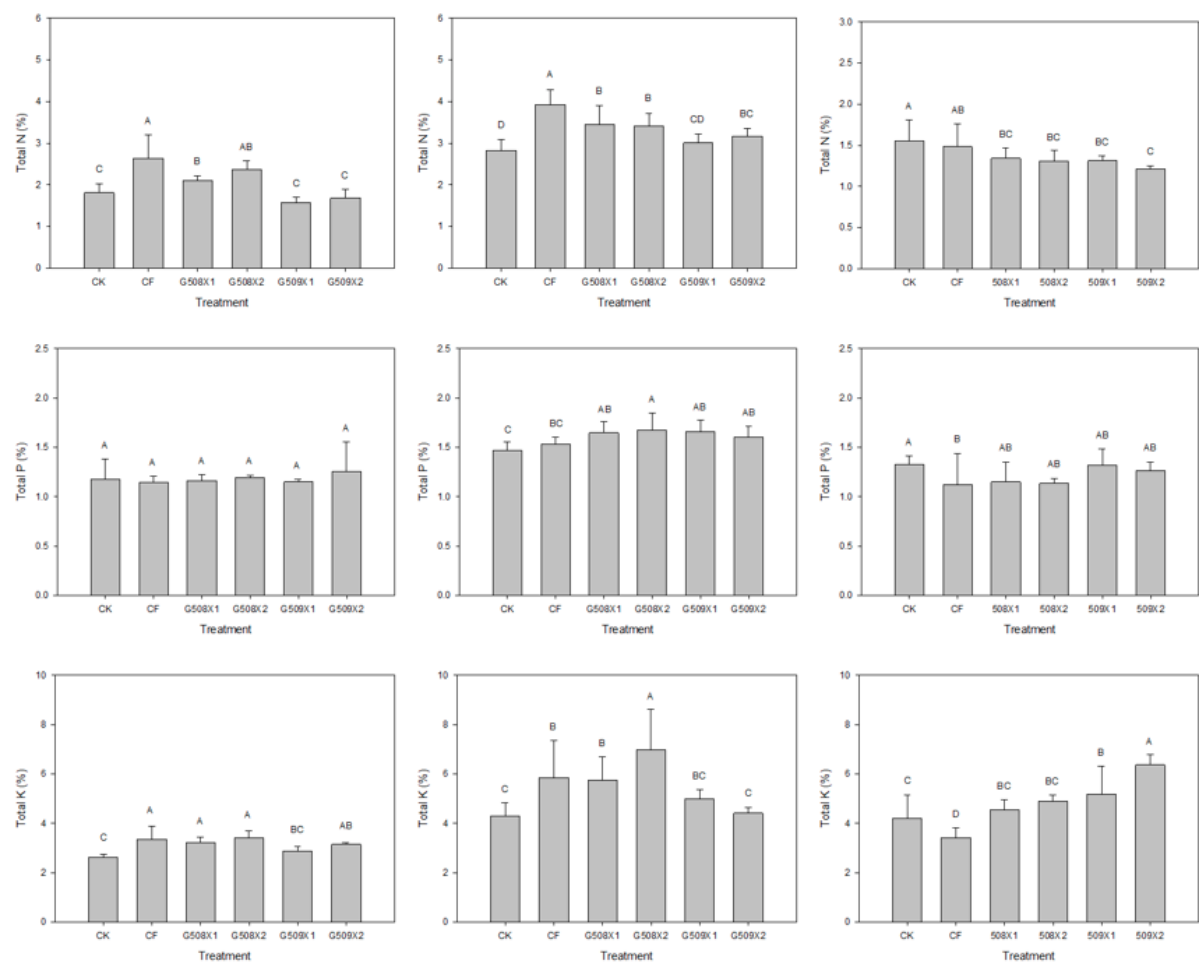
Figure 8. The total concentrations of N, P, and K of the different crops under different treatments: cabbage ( left ), Chinese cabbage ( middle ), and water spinach ( right ). The different letters indicate the significance among the treatments obtained through one-way ANOVA analysis (Duncan test, p < 0.05, n = 4). The codes have the same meanings as those in Figure 1.